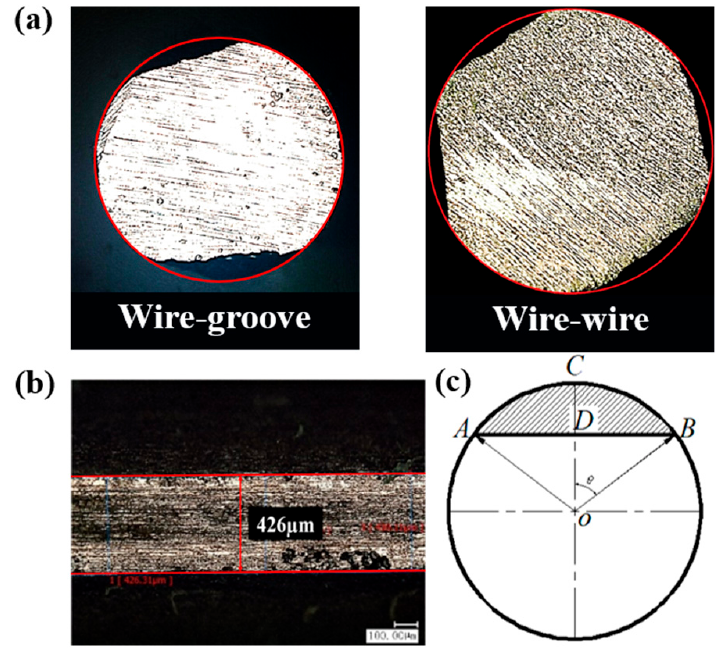
Figure 2. Cross-section diagram ( a ), wear mark profile ( b ), and schematic diagram of failure area ( c ) of the worn steel wire. Table 1. Cross-sectional failure area of fatigue wire (pair: groove) under different contact and fatigue loads.